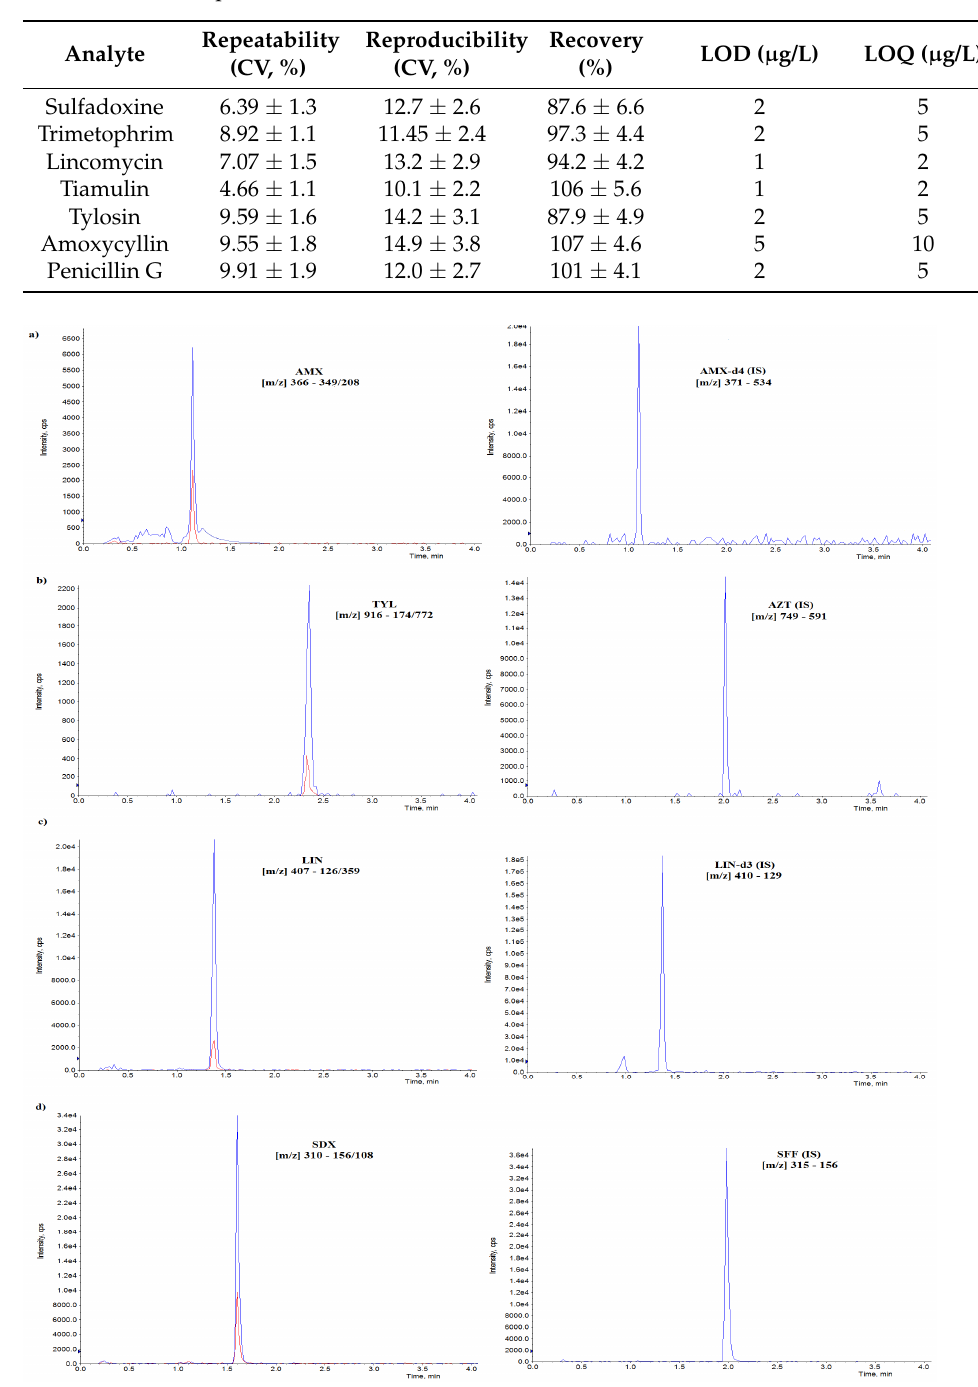
Table 1. Validation parameters.